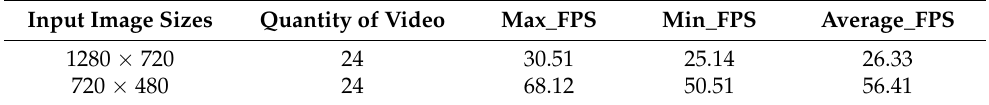
Table 10. FPS of GXLD of different input image